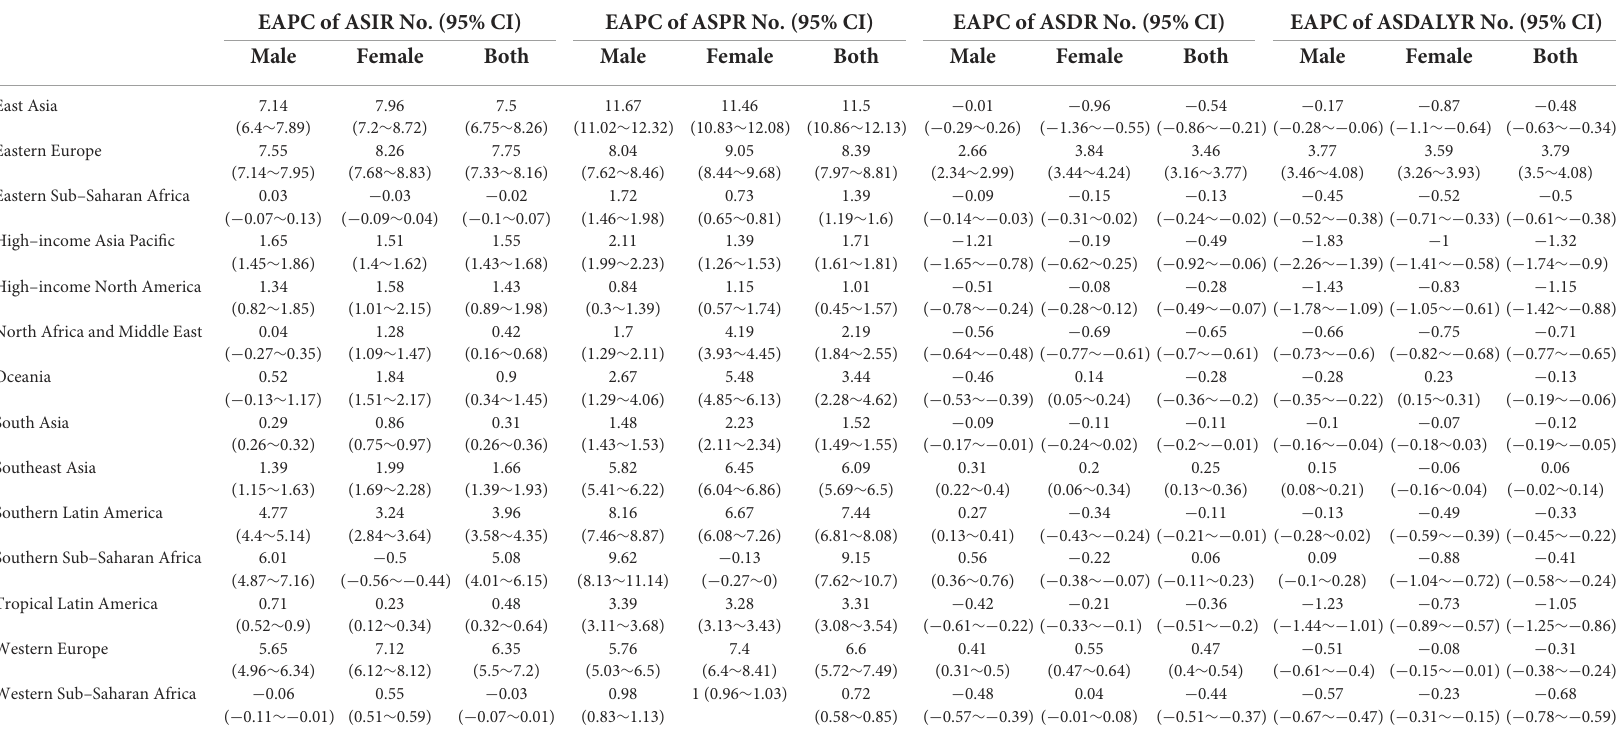
ASIR, the age-standardized incidence rate; ASPR, the age-standardized prevalence rate; ASDR, the age-standardized death rate; ASDALYR, the age-standardized disability-adjusted life years rate; CAVD, calcific aortic valve disease; SDI,